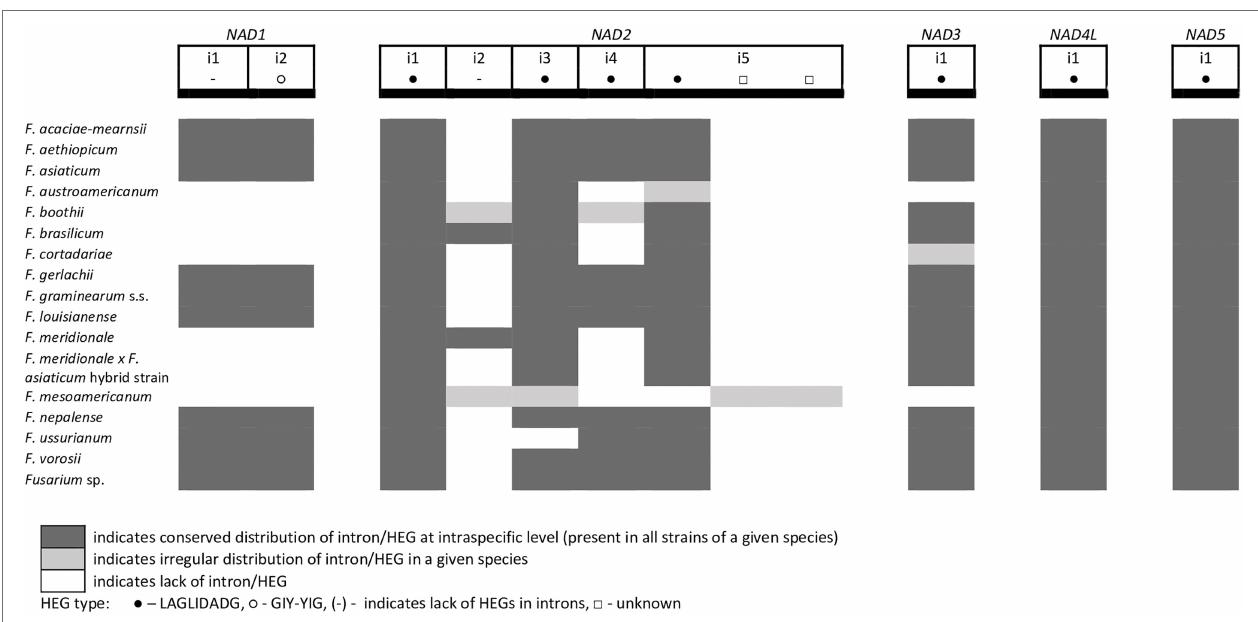
FIGURE 6 | Distribution of introns and associated HEGs found in the NAD genes.